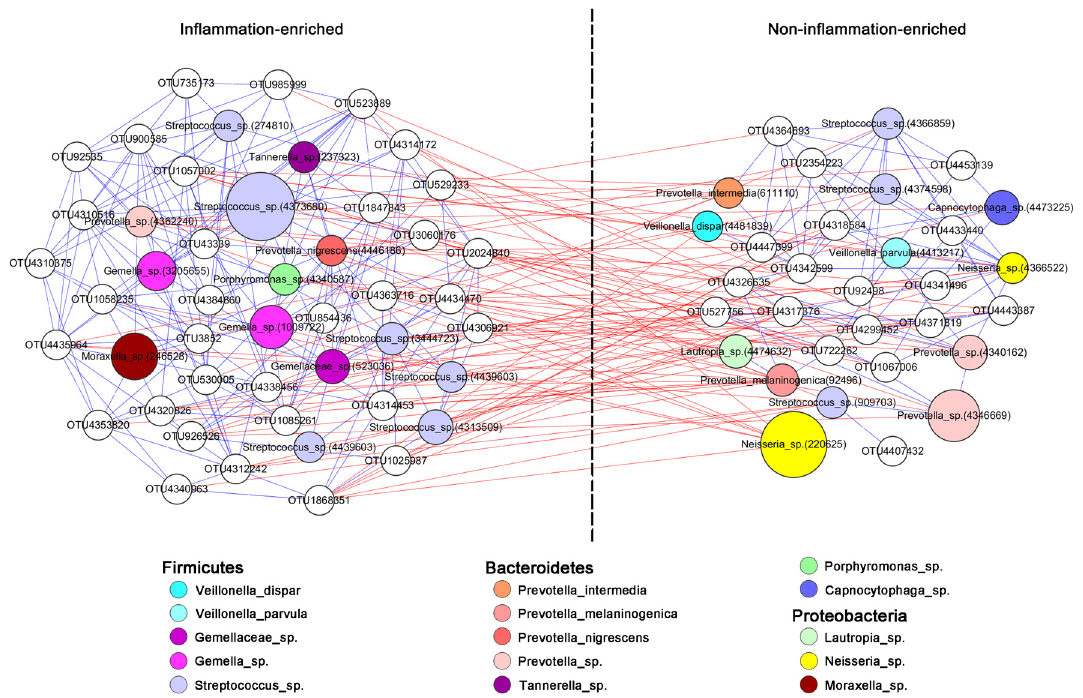
Fig 4. Pre-operative OTUs enriched in saliva samples of inflammation and non-inflammation subjects. Co- occurrence networks were constructed based on the relative abundance profiles of pre-operative OTUs differing between the inflammation and non-inflammation groups. Each node represents a different OTU, and the most abundant OTUs (relative abundance higher than 0.01%) are colored and annotated to indicate the species or unclassified species in a genus (sp.). The sizes of the nodes are proportional to the average relative abundances of the OTUs. Blue and red edges between each pair of OTUs indicate significantly positive and negative correlations, respectively (Spearman ’ s correlation coefficient > 0.4 or < -0.4, P <